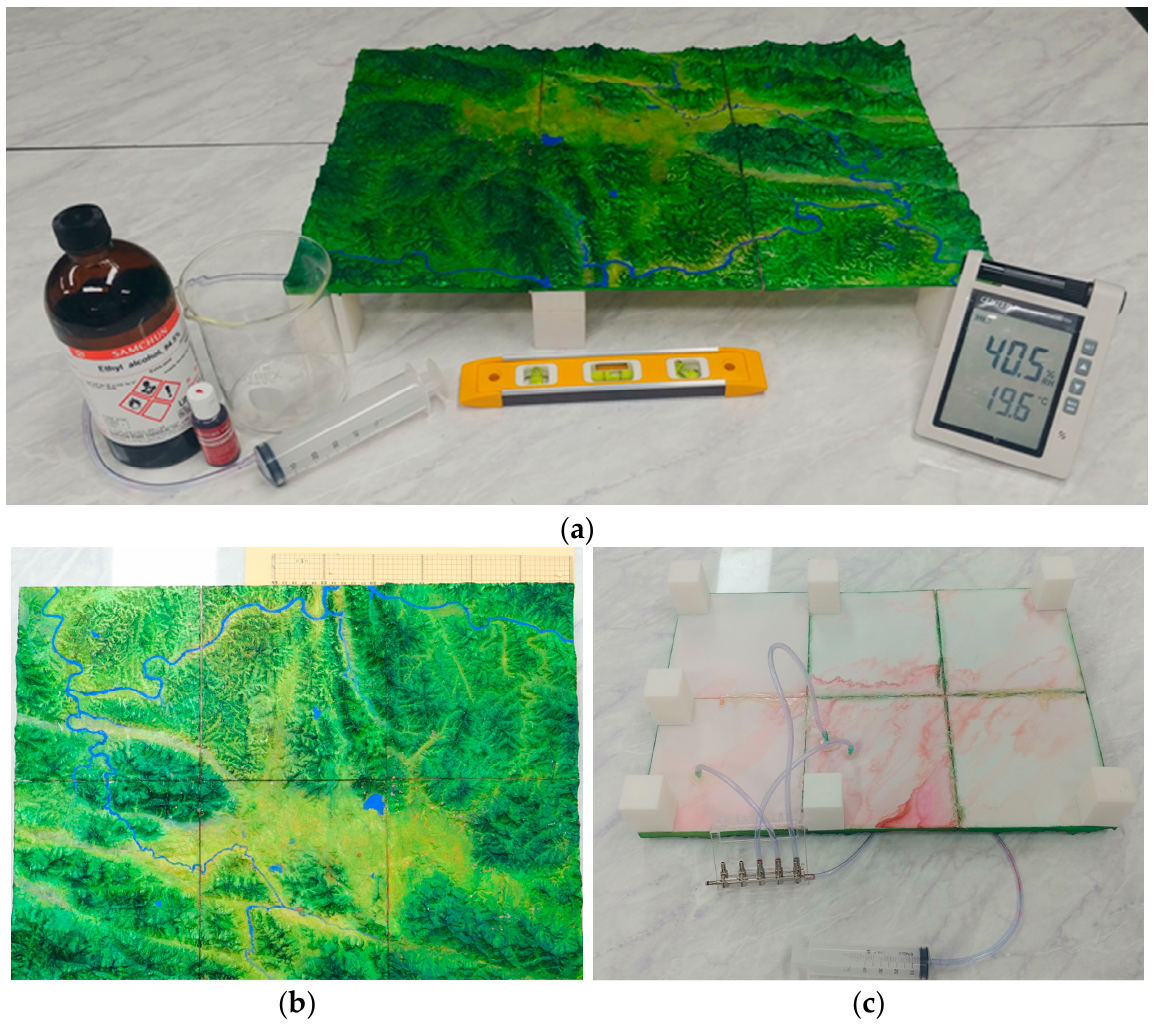
Figure 3. ( a ) Materials for experimental processing; ( b ) top view of the 3D-printed model of the Hantangang River Volcanic Field and ( c ) bottom view of the 3D-printed model consisting of a transparent tube as the connector to the eruptive vent.